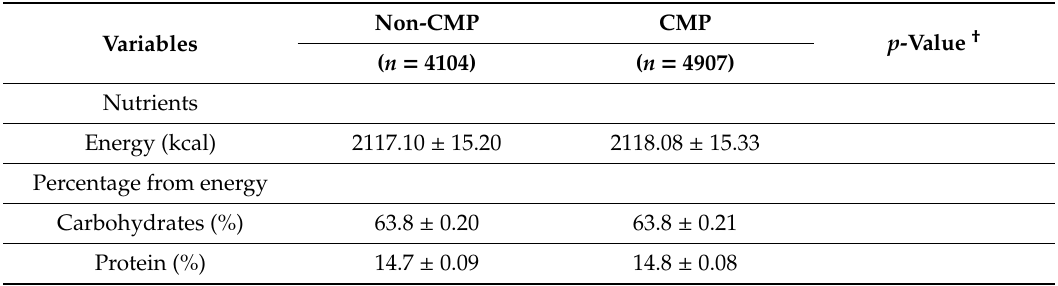
Table 2. Mean daily consumption of food and nutrients according to CMP among adults aged from 19 to 64 years in South Korea (KNHANES VI 2013–2015)